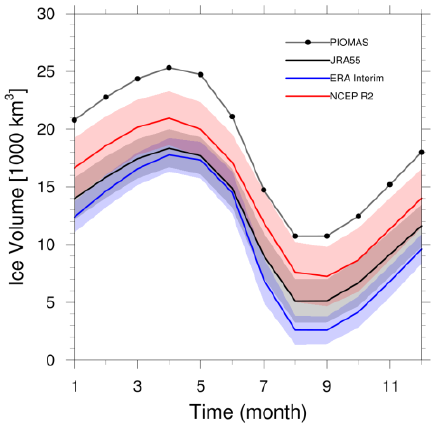
Figure 2. Sea ice volume averaged from 1991 to 2014 in the Arctic region, simulated for forcings from the JRA55, ERA-Interim, and NCEP R2 reanalyses, compared with sea ice volume average from PIOMAS. Colored shading define one standard deviation from each simulation.